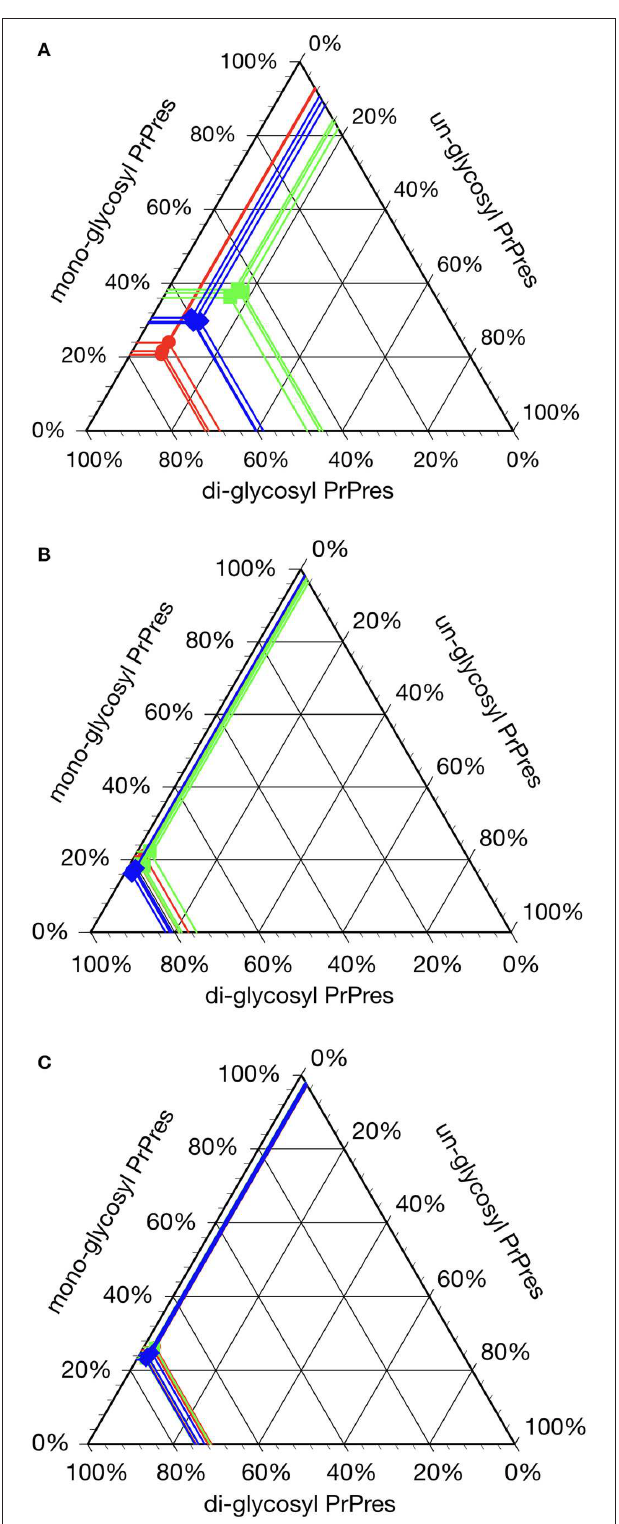
FIGURE 2 | Glycoprofile analysis of C-, L-, and H-BSE strains in different host species. The relative quantity of the three major PrP res bands was determined